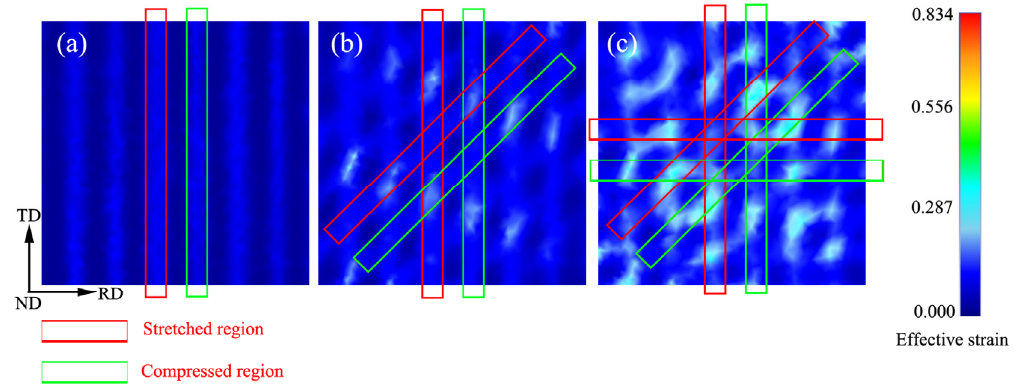
Figure 7. Schematic illustration of the uneven deformation during wavy bending ( a ) 1st pass; ( b ) 2nd pass and ( c ) 3rd pass and ( c ) 3rd pass.